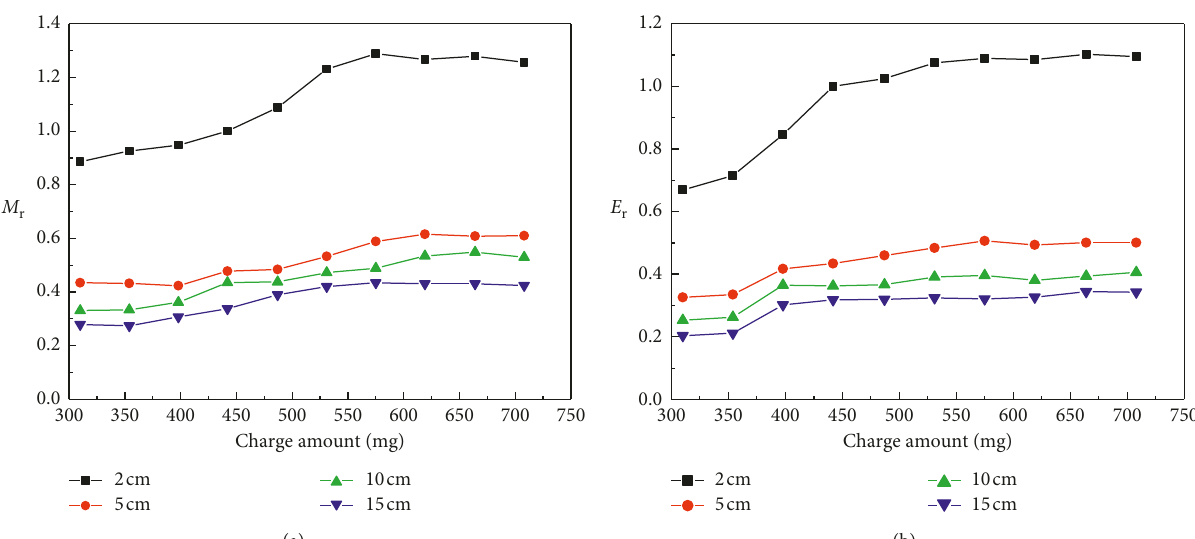
Figure 21: Relationship curves between SRS and charge amount [32]. (a) Maximum coefficient. (b) Mean